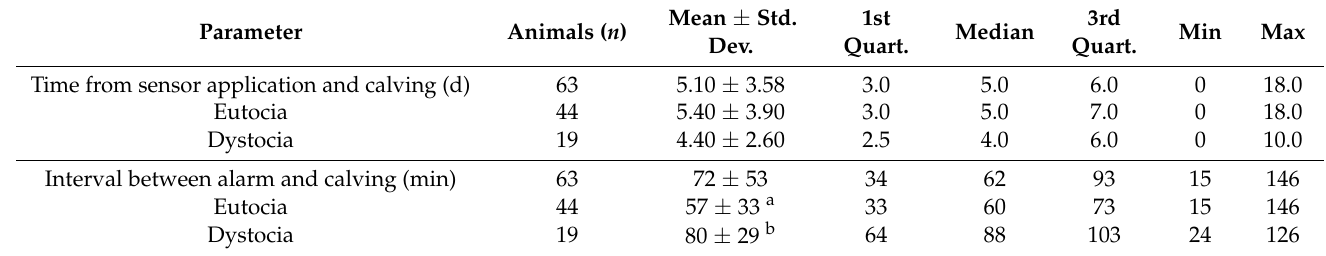
Table 2. Sensor response data. The overall interval from sensor application and calving, for eutocia or dystocia. The overall interval from calving alarm to the complete expulsion of the fetus, and in case of eutocia or dystocia. Parameter Animals ( n )